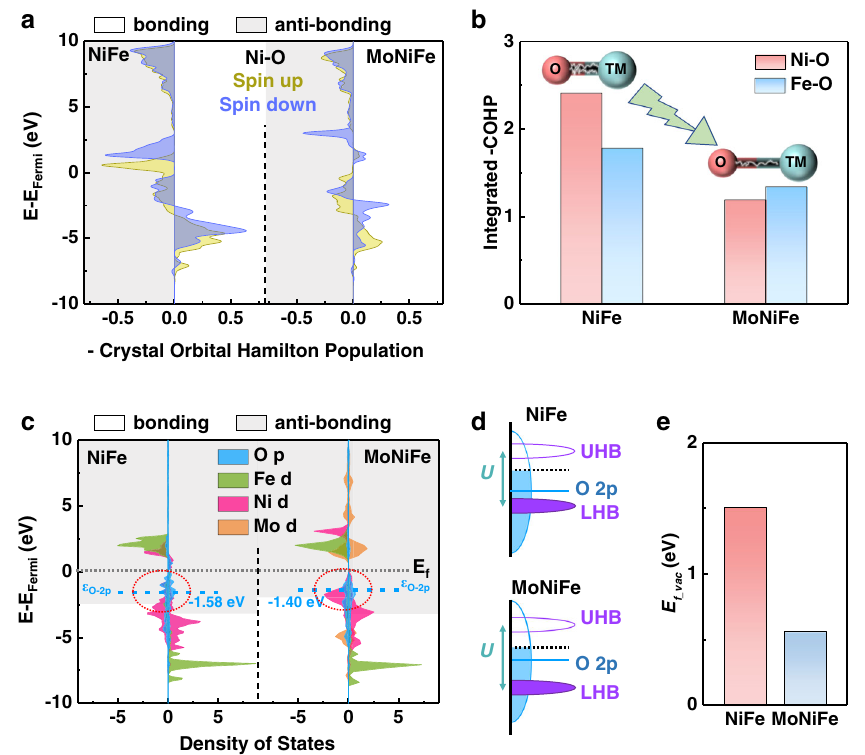
Fig. 5 Lattice oxygen activity determined by density functional theory (DFT) calculations. a Crystal orbital Hamilton populations (COHP) of the Ni-O bond in NiFe and MoNiFe (oxy)hydroxide. b The integrated -COHP up to Fermi level comparison of Ni-O and Fe-O in NiFe and MoNiFe (oxy)hydroxide. TM refers to transition metal. c Projected density of states of NiFe and MoNiFe (oxy)hydroxide. The anti-bonding states below the Fermi level were highlighted by dash circles. d Schematic band diagrams of NiFe and MoNiFe (oxy)hydroxide. The d -orbitals split into electron- fi lled lower Hubbard band (LHB) and empty upper Hubbard band (UHB) with an energy difference of U . e The oxygen vacancy formation energy ( E f_vac ) of NiFe and MoNiFe